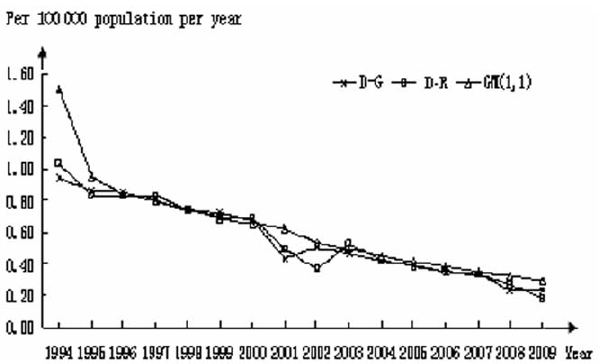
Figure 4. Mortality of HIV-negative TB patients in Germany; a comparison between actual (D-G) and calculated datasets using the D-R and GM(1,1) models.